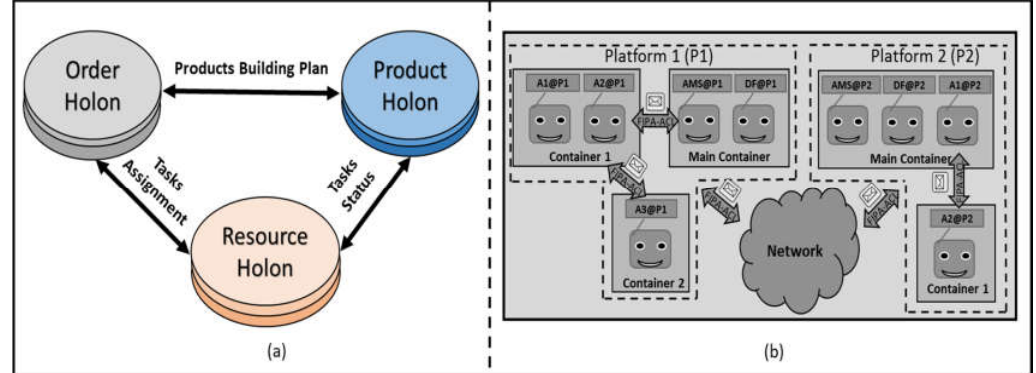
Figure 3. ( a ) PROSA (Product-Resource-Order-Staff-Architecture) model; ( b ) JADE (JAVA Agent Development Environment) framework.